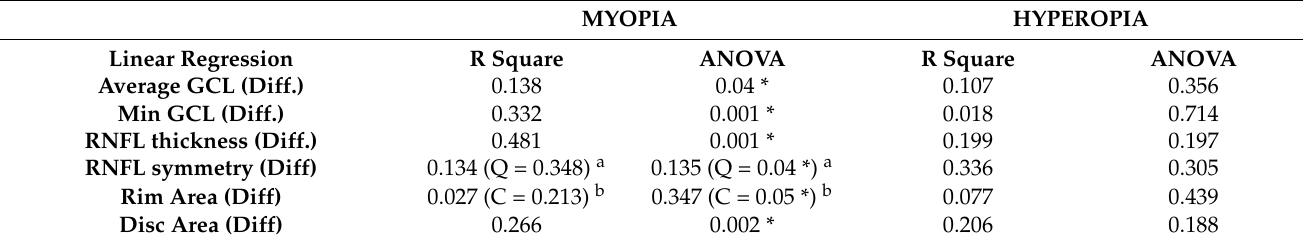
Figure 2. OCT scans of RNFL and GCL in a patient ( A ) before and ( B ) after correction. Table 3. Regression analyses comparing differences (before and after correction) with SE-Q = quadratic regression; C = cubic regression; a = significant for quadratic regression; b = significant for cubic regression; * = significant for linear